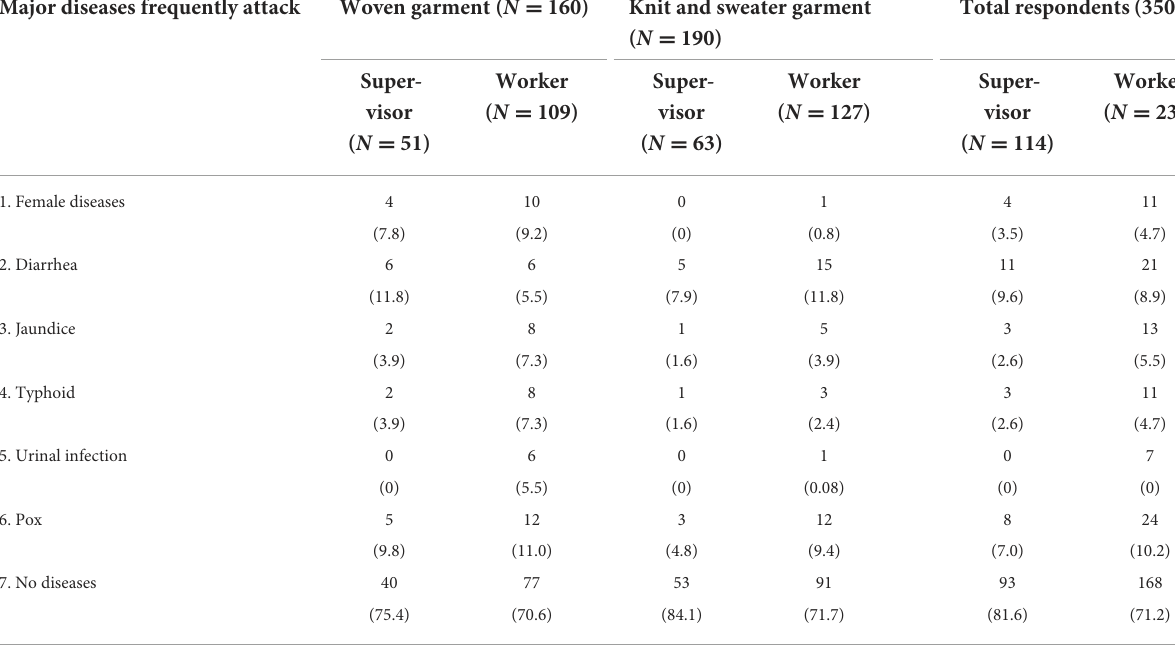
TABLE 13 Major diseases frequently attack the different category of respondents ( N = 350).